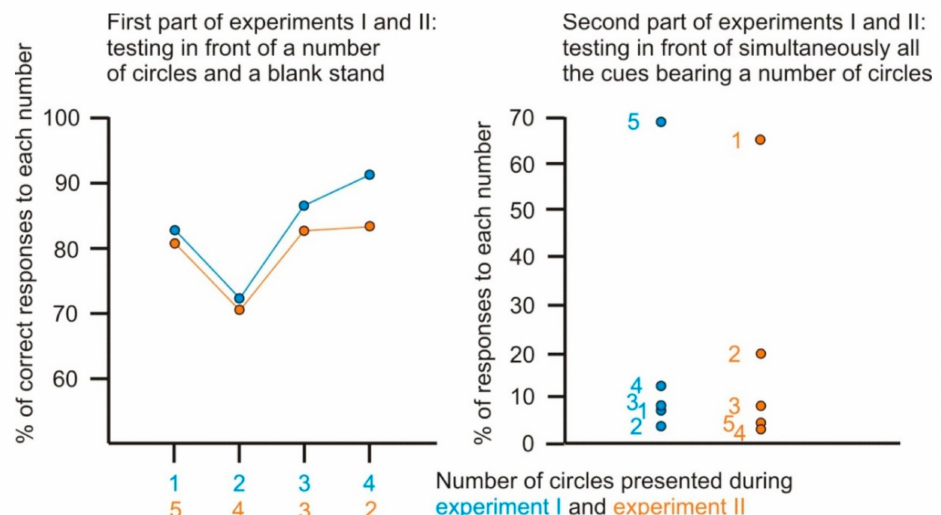
Figure 2. Graphical representation of the results. The ants of two colonies were trained to successively 1, 2, 3, 4 circles (blue dots) or 5, 4, 3, 2 circles (yellow dots) set near their food, and they duly acquired this learning (left graph). After this (right graph), they were tested in front of simultaneously 1, 2, 3, 4, 5 circles and reacted then mostly to the 5 circles (blue dots) or the 1 circle (yellow dots), having thus correctly anticipated the following number in an increasing and in a decreasing sequence of elements. A similarity appeared between the ants’ responses in the course of the experiment I relative to an increasing sequence (blue dots) and of the experiment II relative to a decreasing sequence (yellow